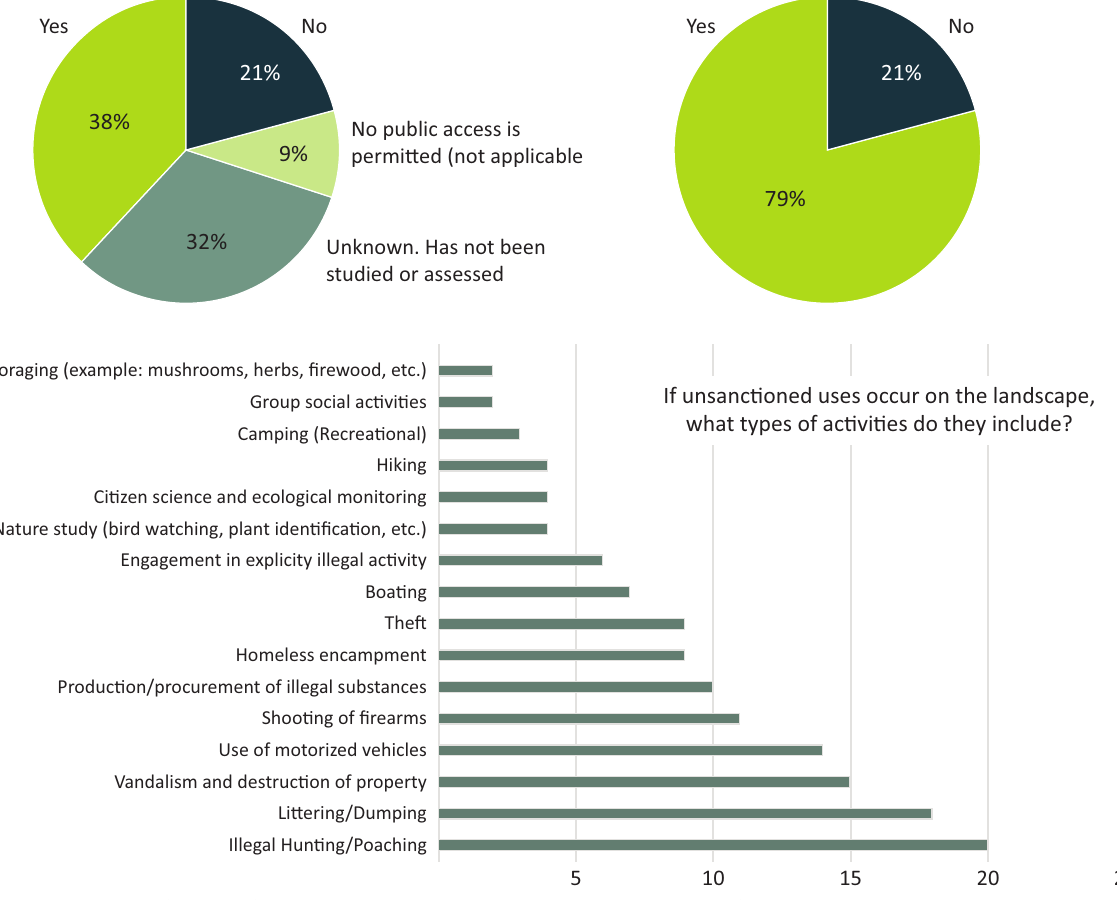
Figure 6. Selection of results from the project survey assessing perceptions of human uses and landscape boundary con- ditions. The complete survey results are available in the project report (Milligan & Kraus-Polk,